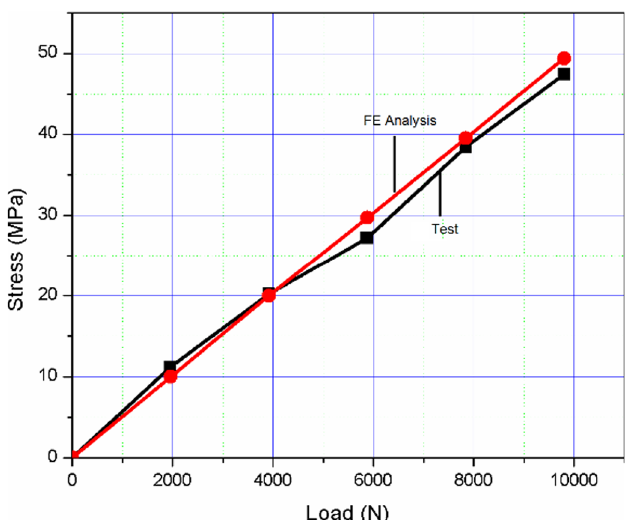
Fig. 10. Test & FE results at gauge-4 location.